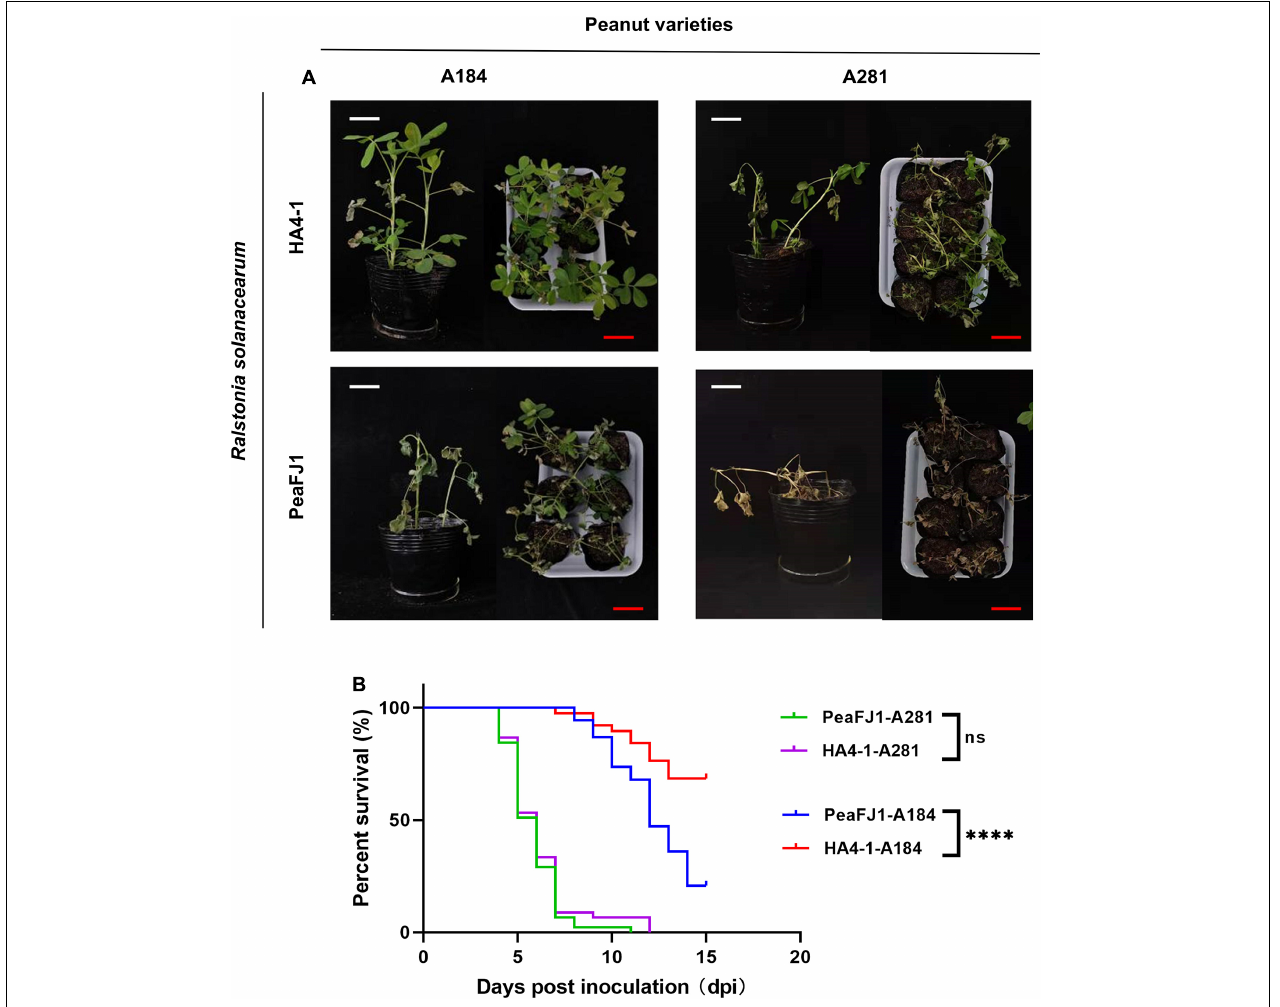
FIGURE 1 | R. solanacearum PeaFJ1 shows different virulent profiles compared with HA4-1 in peanut varieties. Bacterial wilt symptoms (A) and survival ratio (B) of the peanut varieties A184 and A281 infected with R. solanacearum PeaFJ1 and HA4-1, respectively. (A) Photographs from representative plants were taken at 10 days post- inoculation. White scale bars = 5 cm, red scale bars = 10 cm. (B) The percentage of surviving peanuts was recorded for 15 days. The data used for the survival ratio were collected from three independent experiments. Gehan–Breslow–Wilcoxon test p -values are < 0.0001 and 0.6471 in A184 and A281, respectively. ∗∗∗∗ indicates p < 0.0001, (ns) means no significantly